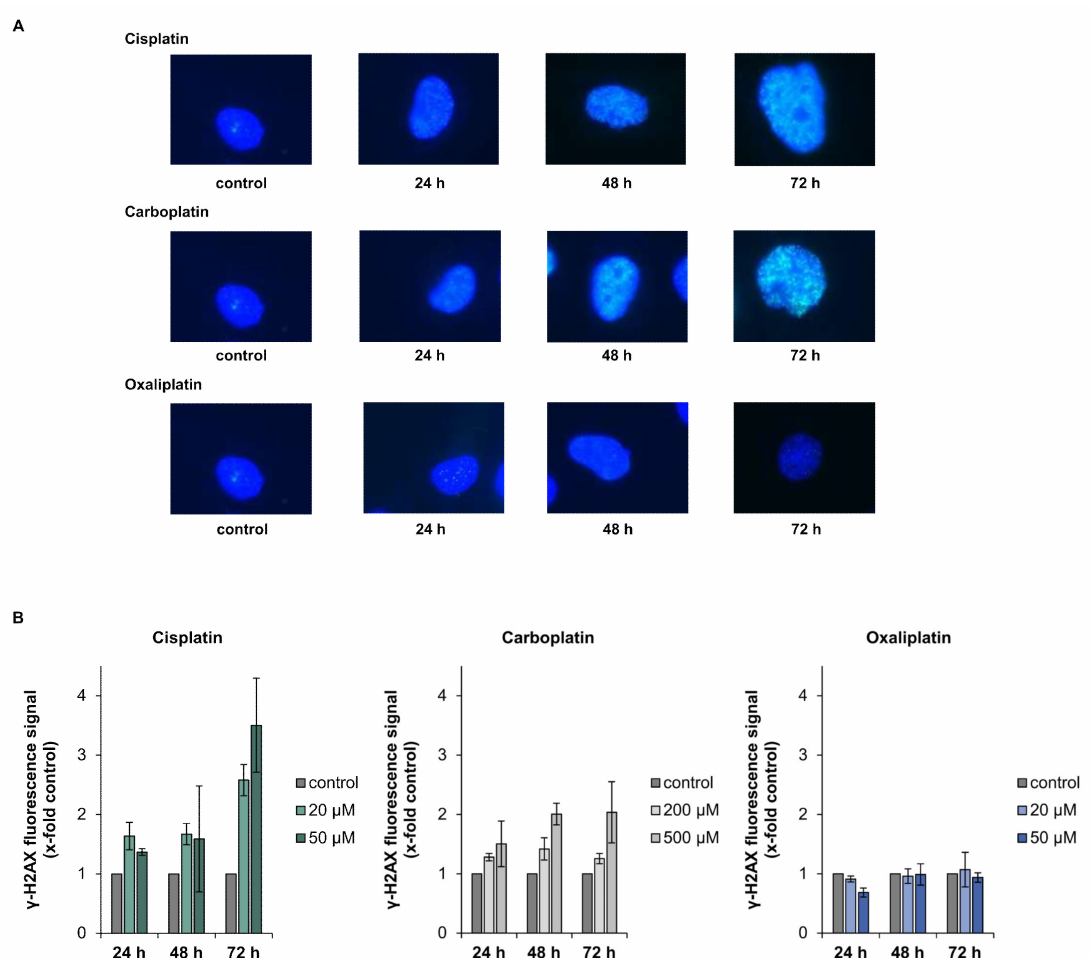
Figure 6. Analysis of γ -H2AX after incubation of A498 cells with cisplatin, carboplatin or oxaliplatin. Cells were treated with cisplatin or oxaliplatin (20, 50 µ M) or carboplatin (200, 500 µ M), followed by postcultivation of 24, 48 or 72 h. γ H2AX fluorescence was measured using fluorescence microscopy. ( A ): Representative microscope pictures of A498 cells treated with the platinum-based compounds at the highest concentration. ( B ): Quantification of the fluorescence signal. Overall γ -H2AX fluorescence was evaluated and values were normalized to the untreated control. The mean values are shown of three independent experiments ± standard